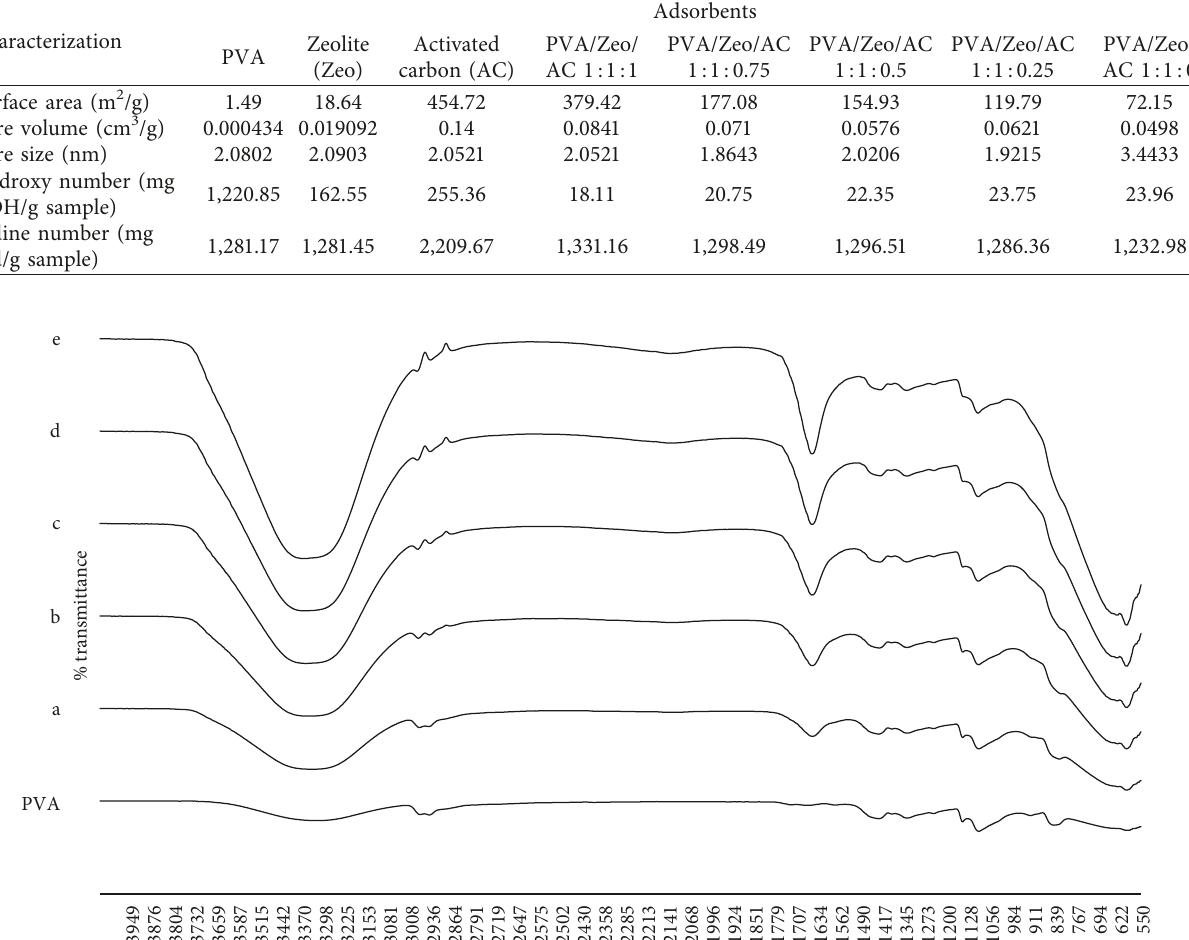
Table 1: Physicochemical properties for individual and composite adsorbents.